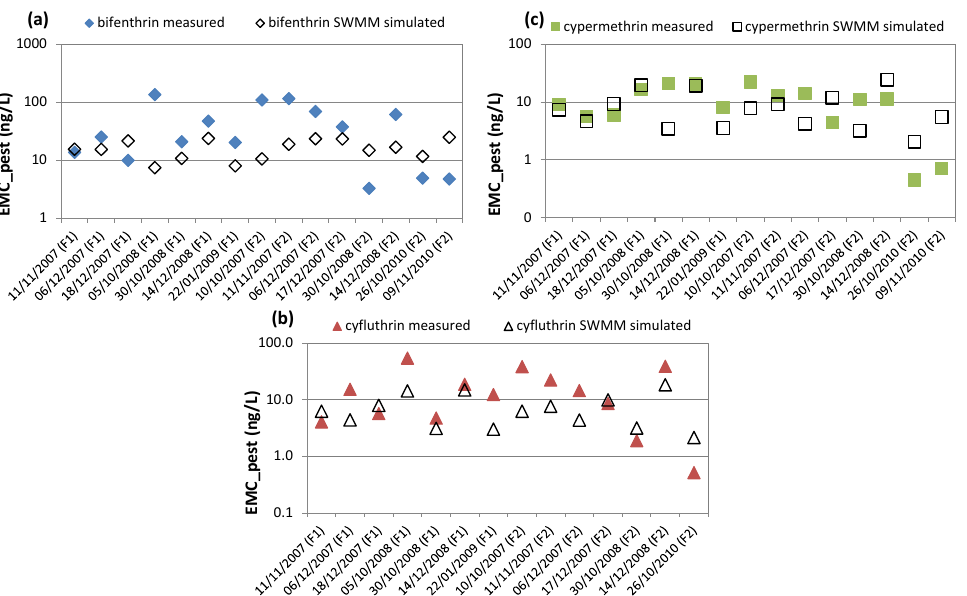
Figure 9. Comparison between observed and predicted Event Mean Concentration (EMC) of ( a ) bifenthrin, ( b ) cyfluthrin, and ( c ) cypermethrin. The predictions are obtained with Storm Water Management Model (SWMM). Table 1. Numerical comparison between the simulated and measured EMCs and EMLs for each rainfall event.